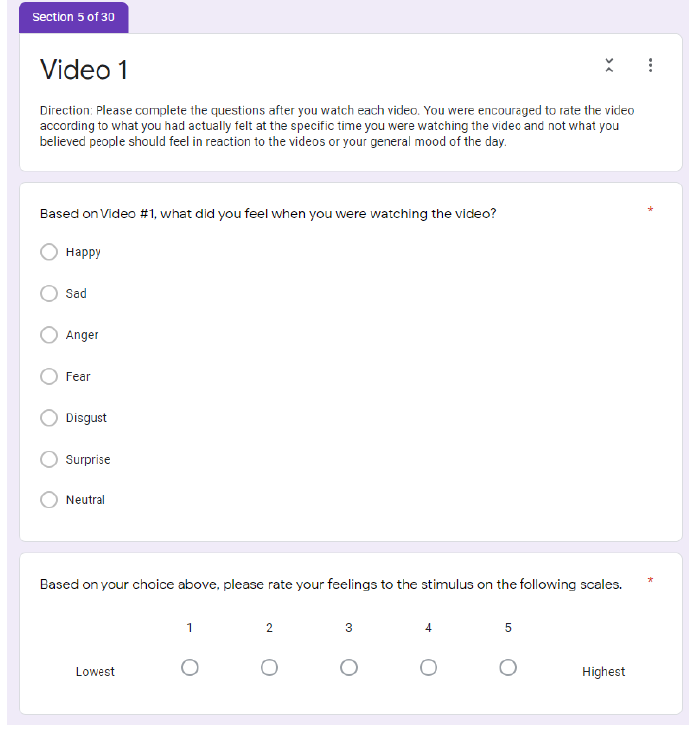
Figure 3. The self-assessment form prepared in Google Forms.